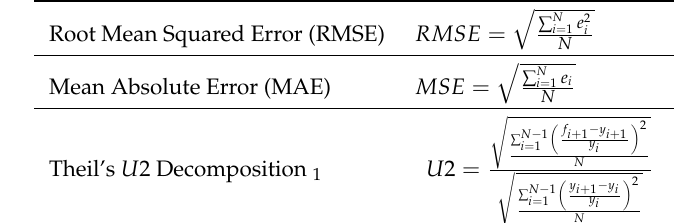
Table 2. The most common set of forecast evaluation